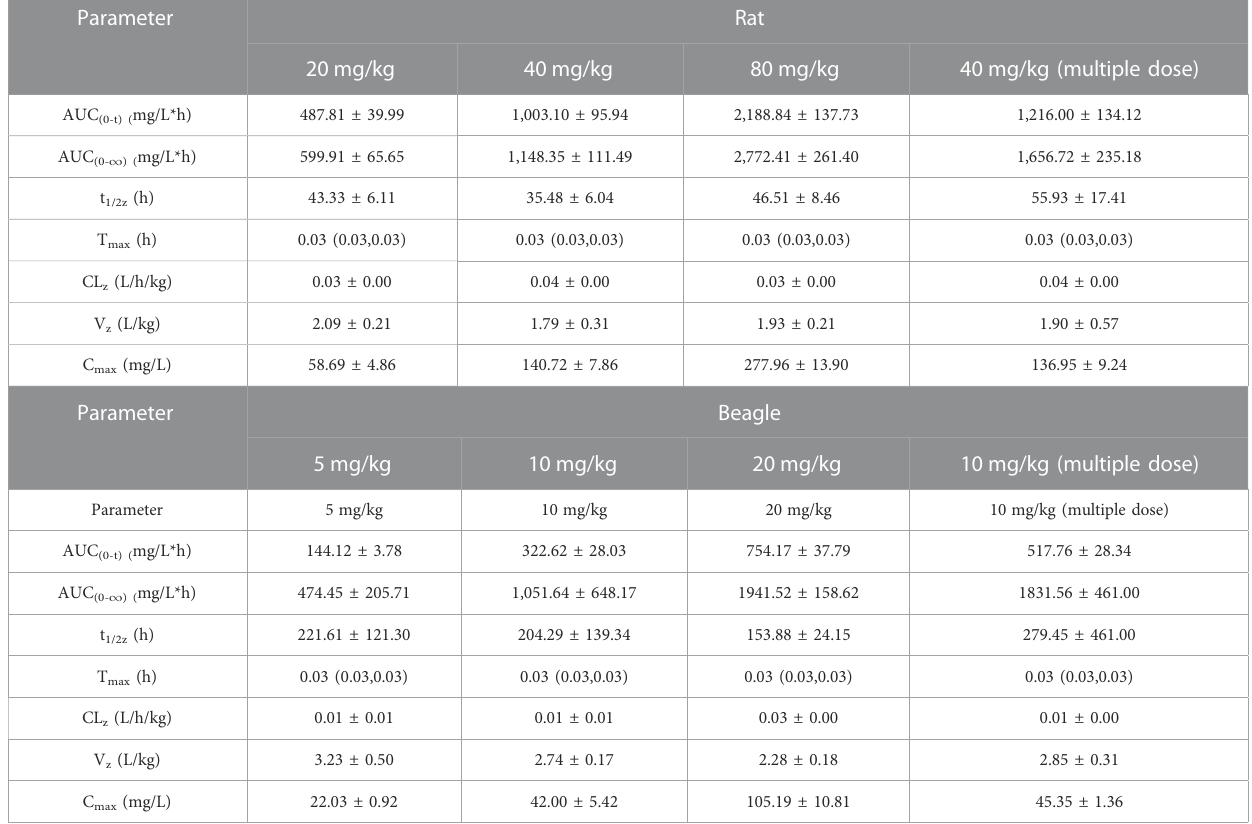
TABLE 3 Pharmacokinetic parameters of SEP after intravenous injection in rats ( n = 6) and beagles ( n = 4).